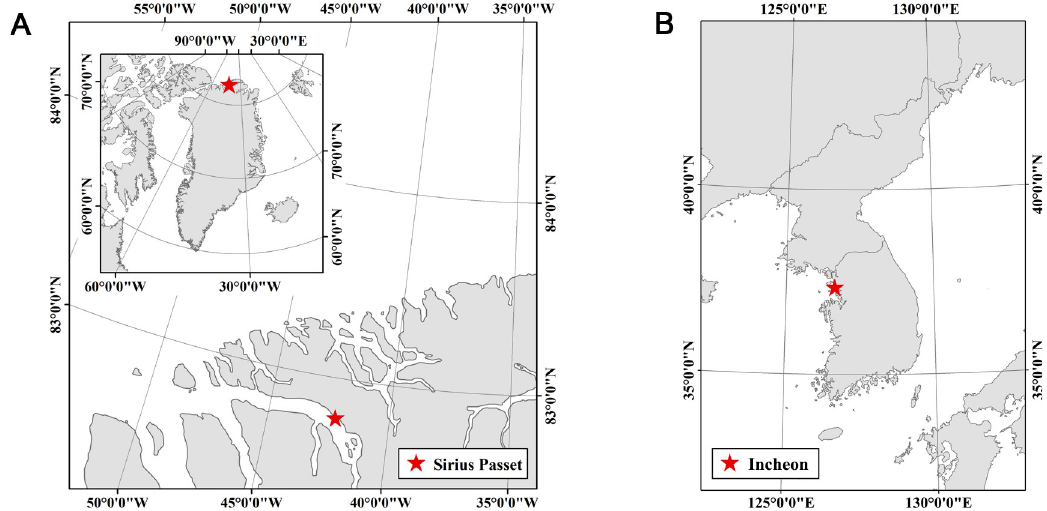
Fig 1. The location of our study site. (A) Sirius Passet, at the latitude 82˚47.6´N and longitude 42˚13.7´W in North Greenland. (B) Incheon, 37˚21.1’N, 126˚39.1’E in the Republic of